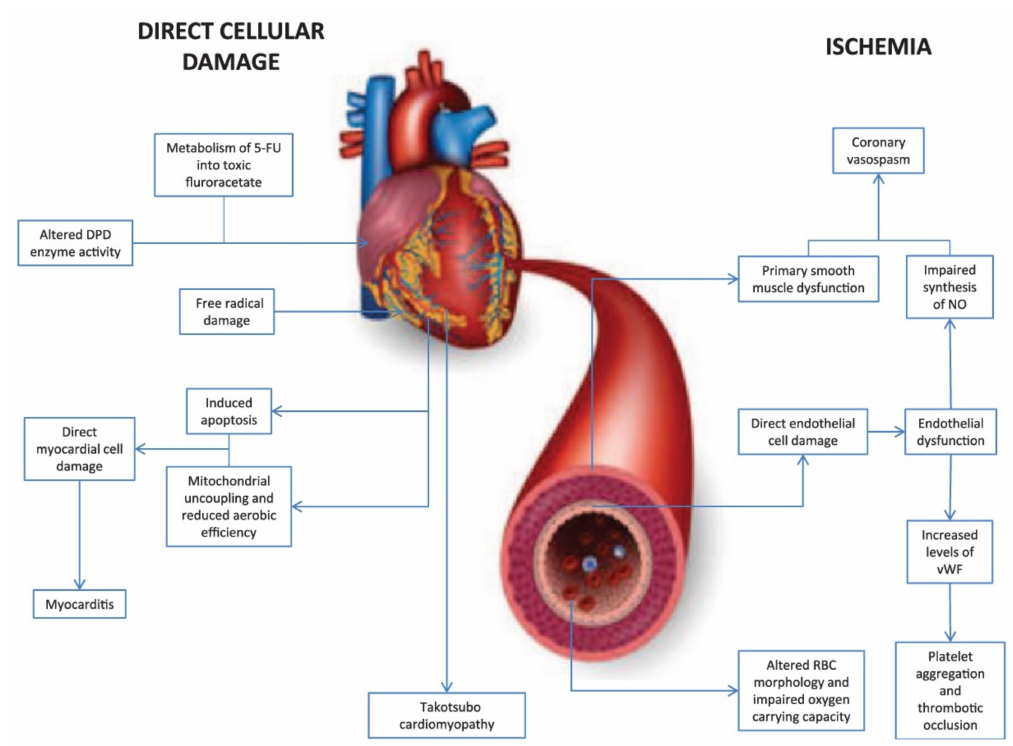
Figure 3. Diagrammatic representation of two major mechanisms of 5-fluorouracil-induced cardiotoxicity.